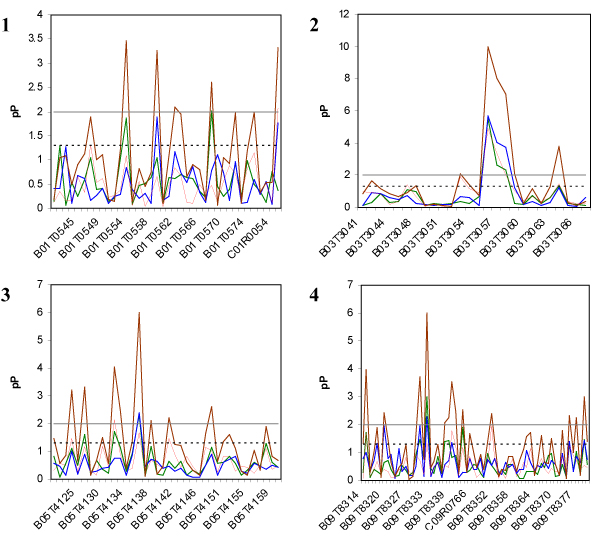
Results of fine mapping using the WA method for chromosomes 1, 3, 5, and 9. Average of 5 replicates. The plots show the fine mapping results using the WA method for chromosomes 1, 3, 5, and 9 in panels 1–4, respectively: blue line, Aipotu population, 100 cases and 100 controls; red line, Karangar population, 100 cases and 100 controls; green line, Danacaa population, 100 cases and 100 controls; brown line, the three samples pooled, 300 cases and 300 controls.